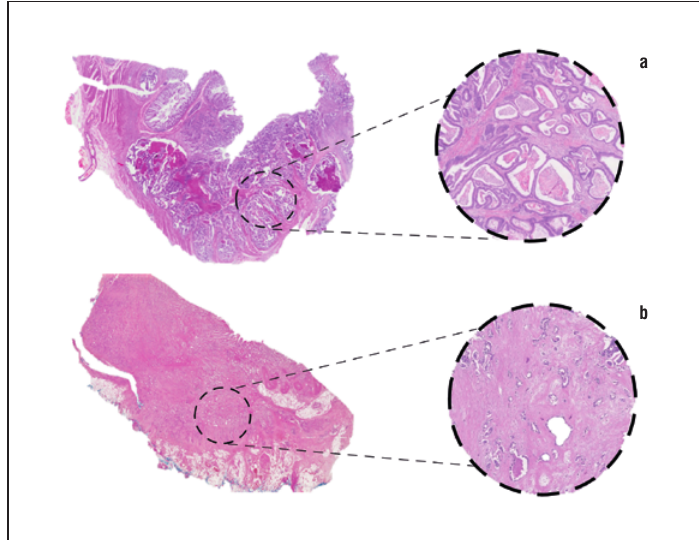
Figure 1. Standardized scoring of stromal estimation in colorectal adenocarcinoma. Selection of the area with the highest amount of stroma with tumor cells present at all borders of the image field: a) Case No. 190, b) Case No. 291. Hematoxylin-eosin; magnifications ×2 and